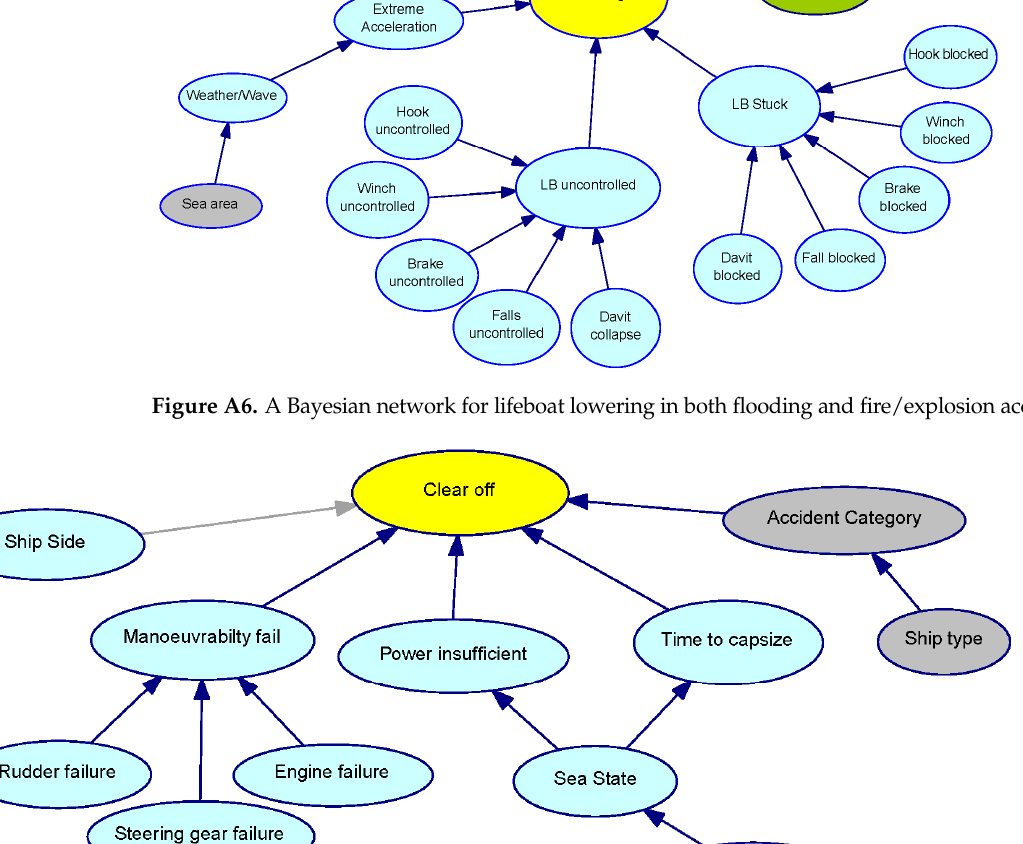
Figure A7. A Bayesian network for lifeboat clearing in flooding accidents (06).